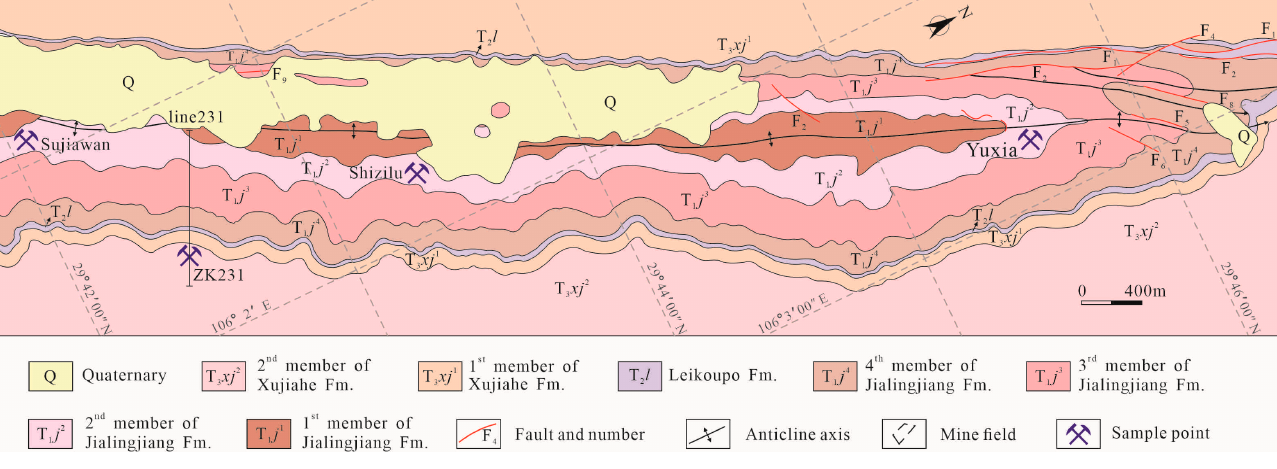
Figure 2. Geological map of the deposits in the Xishan anticline, showing the sampling